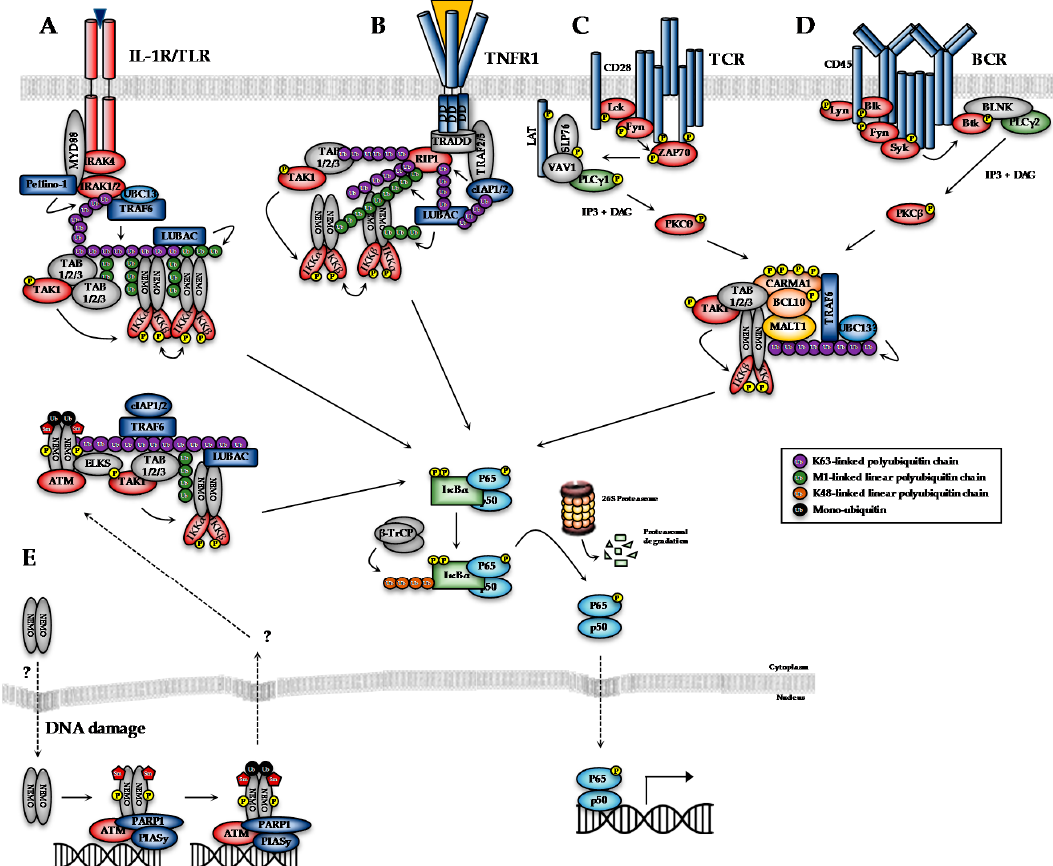
Figure 1. Overview of canonical and DNA damage-induced NF- κ B signalling pathways. ( A ) Binding of IL-1/Toll-like receptor (TLR) ligands to the interleukin-1 receptor (IL-1R)/TLRs leads to the assembly of the so-called ‘Myddosome’, an oligomeric structure consisting of the adaptor protein MyD88, IL-1 Receptor (IL-1R)-Associated Kinase 4 (IRAK4), IRAK1 and IRAK2. IRAK4 activates